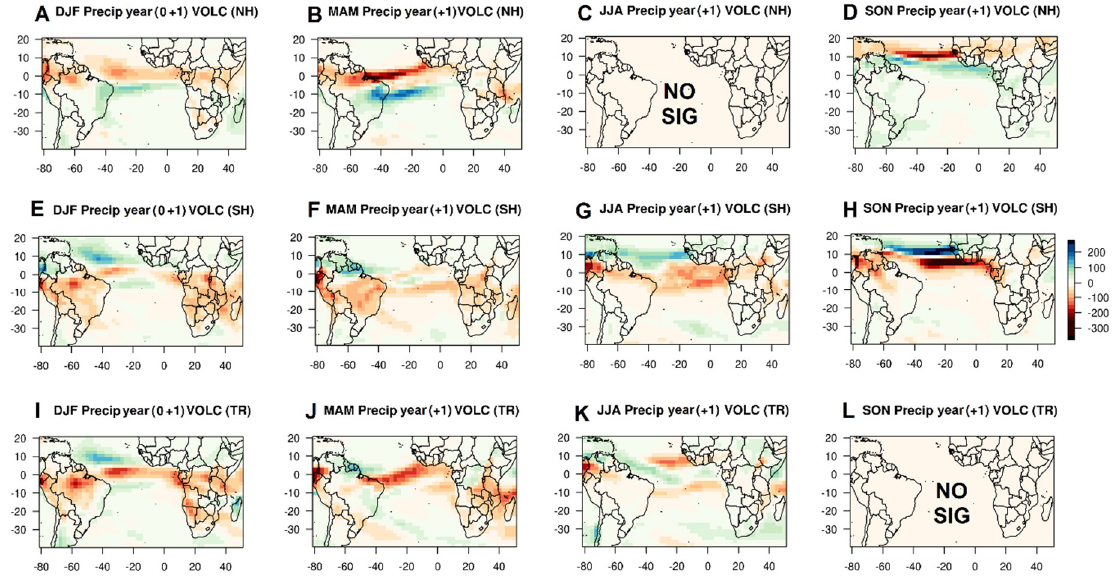
Figure 10. VOLC precipitation composites (mm/3 months) for one year after volcanic eruption as listed in Table 1. Lines correspond to the class of the eruptions (NH—( A – D ); SH—( E – H ); and TR —( I – L )), and columns refer to the seasonal SEA (DJF, MAM, JJA, and